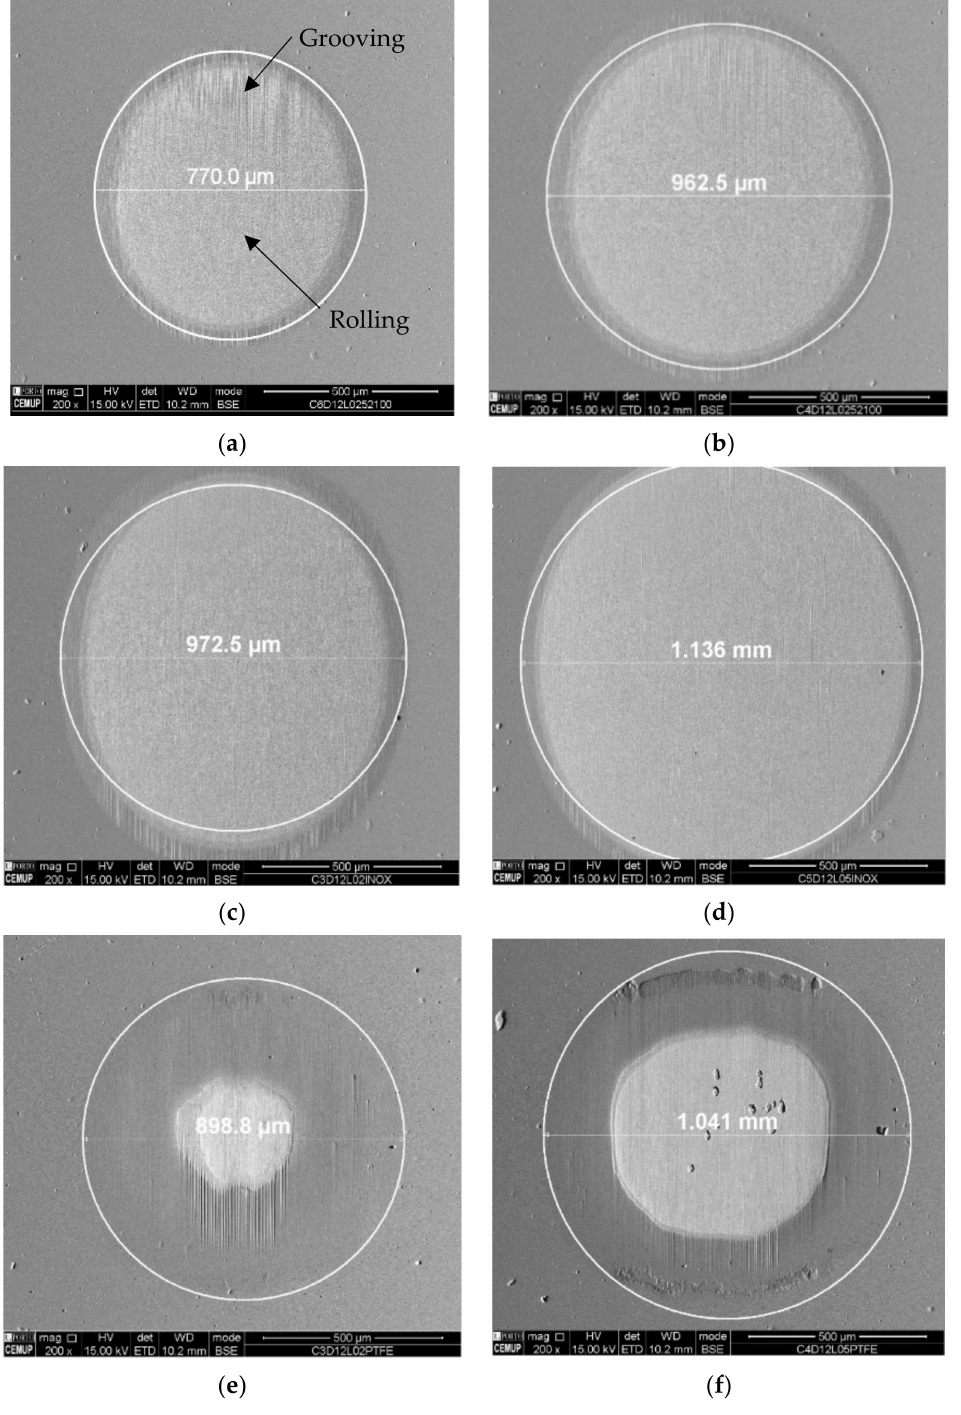
Figure 13. Wear craters generated on tests performed with diamond powder (1–2 µ m) abrasive particles: ( a ) AISI 52100; load 0.2 N, ( b ) AISI 52100; load 0.5 N, ( c ) SS AISI 304; load 0.2 N, ( d ) SS AISI 304; load 0.5 N, ( e ) PTFE; load 0.2 N, ( f ) PTFE; load 0.5